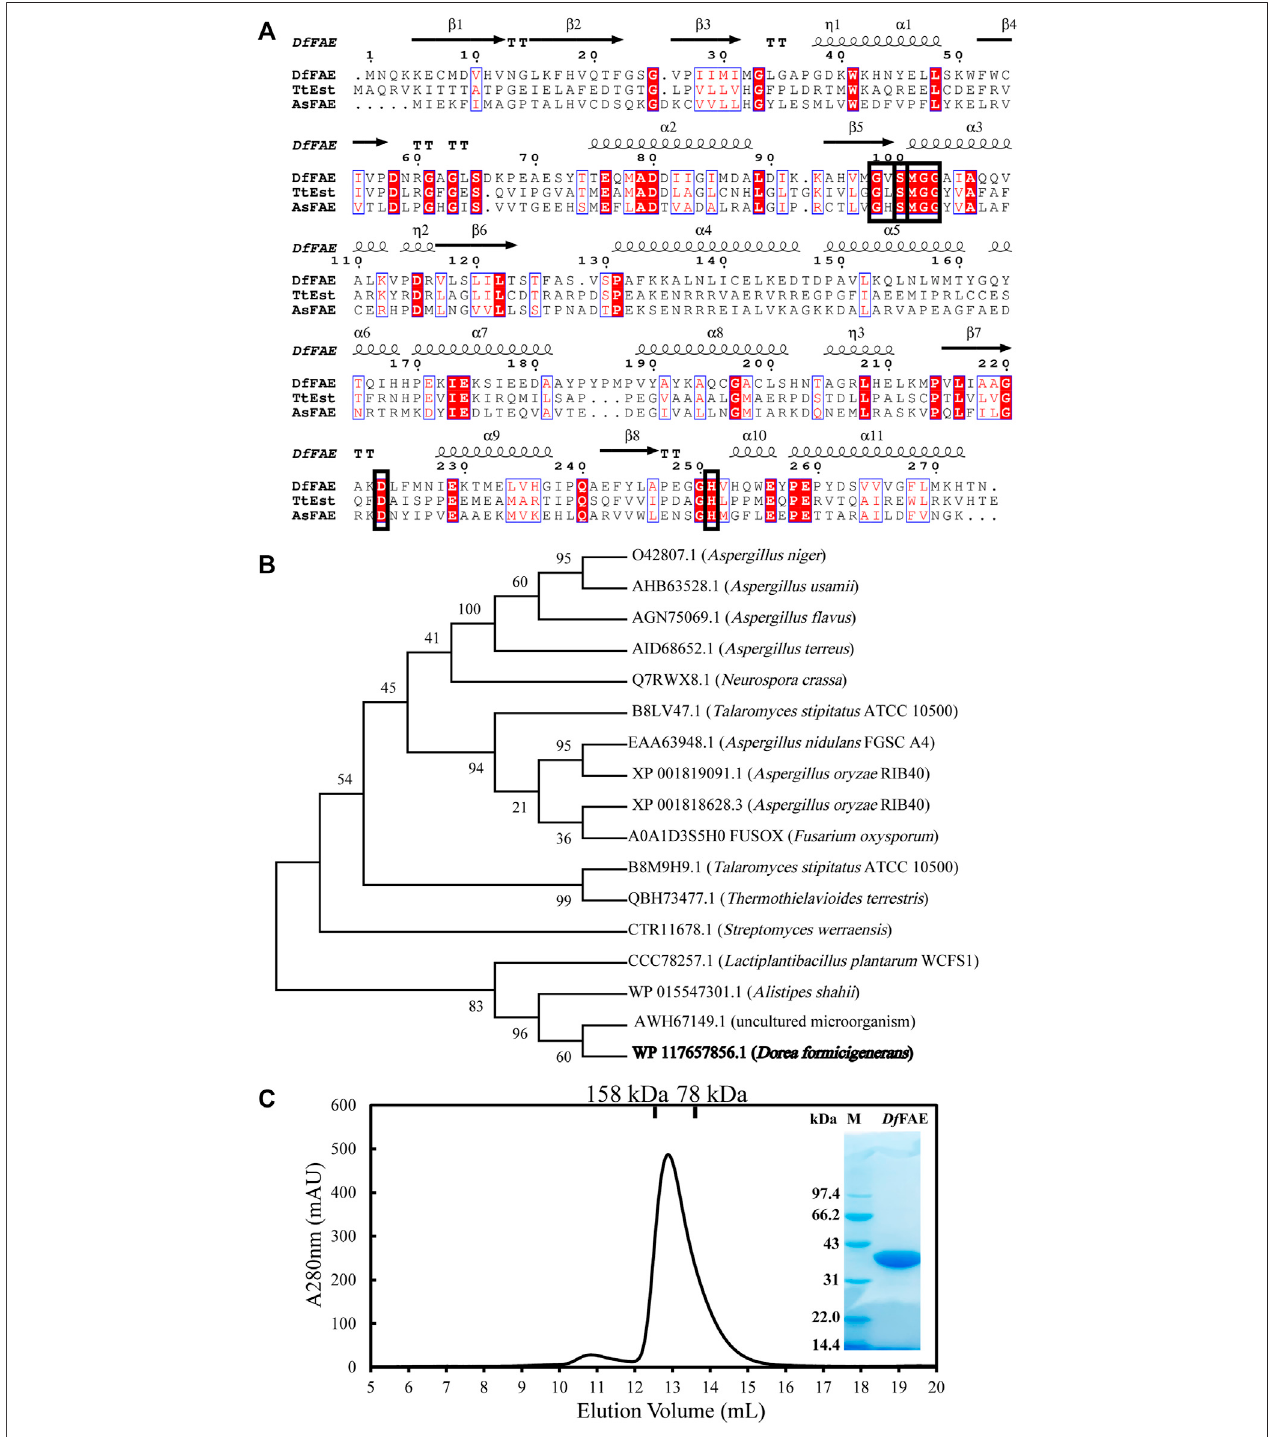
FIGURE1| Sequenceanalysisandproteinexpressionandpuri fi cationof Df FAE. (A) Aminoacidsequencealignmentof Df FAE, Ts Estand As FAE.TheClustalX 2.0 tool was used to align the sequences, and the ESpript 3.0 program was used to display them. The alpha helices and beta strands are displayed above the sequences denoted as α and β , respectively. The red background denotes highly conserved residues. The black box denotes the highly conserved catalytic triad and pentapeptide GXSXG motif (B) Phylogenetic tree analysis of Df FAE and other classi fi ed FAEs. The sequences in the phylogenetic tree are, from top to bottom, An FAEA (O42807.1) of Aspergillus niger ; Au FaeA (AHB63528.1) of Aspergillus usamii ; Af FaeA (AGN75069.1) of Aspergillus fl avus ; At FaeA (AID68652.1) of Aspergillus terreus ; Nc FaeD-3.544 (Q7RWX8.1) of Neurospora crassa ; Ts FaeC (B8LV47.1) of Talaromyces stipitatus ; AN 1772.2 (EAA63948.1) of Aspergillus nidulans ; Ao FaeB